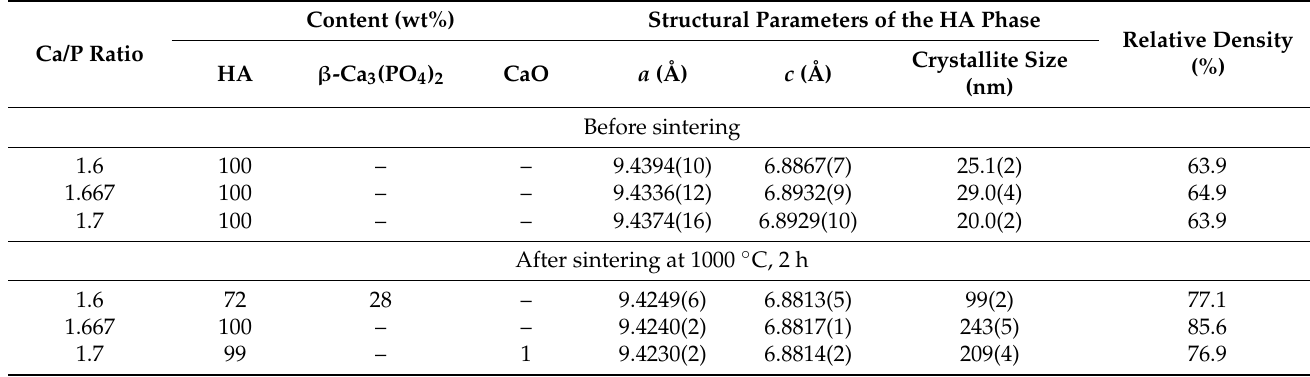
Table 2. Phase composition, structural parameters of HA phase and relative density of the pellets with different Ca/P ratio before and after sintering in the high-temperature